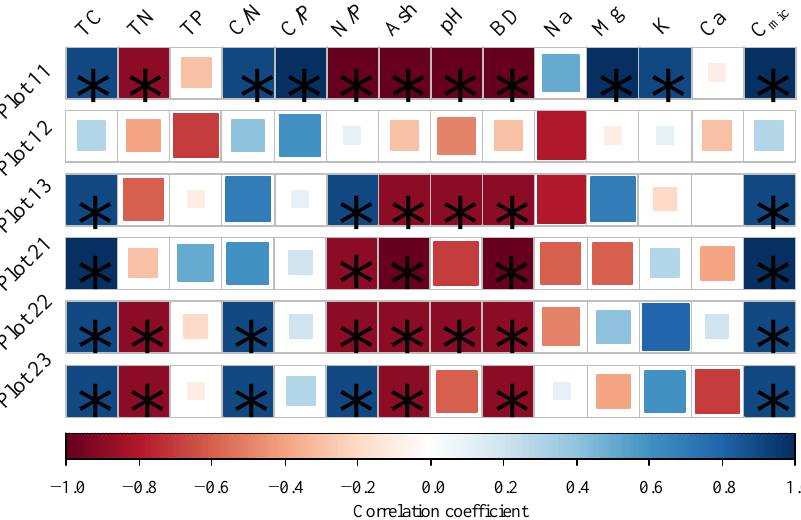
Figure 4. Correlation coefficients after Spearman (significant correlations ( p < 0.05) are marked with asterisks) for the soil basal respiration rates separated into the plots (TC: total carbon concentration, TN: total nitrogen concentration, TP: total phosphors concentration, C/N: carbon to nitrogen ratio, C/P: carbon to phosphors ration, Ash: ash content, pH: pH value, BD: bulk density, Na: sodium concentration, Mg: magnesium concentration, K: potassium concentration, Ca: calcium concentra- tion, C mic : microbial biomass carbon, C mic /C org : microbial entropy, BR: basal respiration rate, and qCO 2 : metabolic